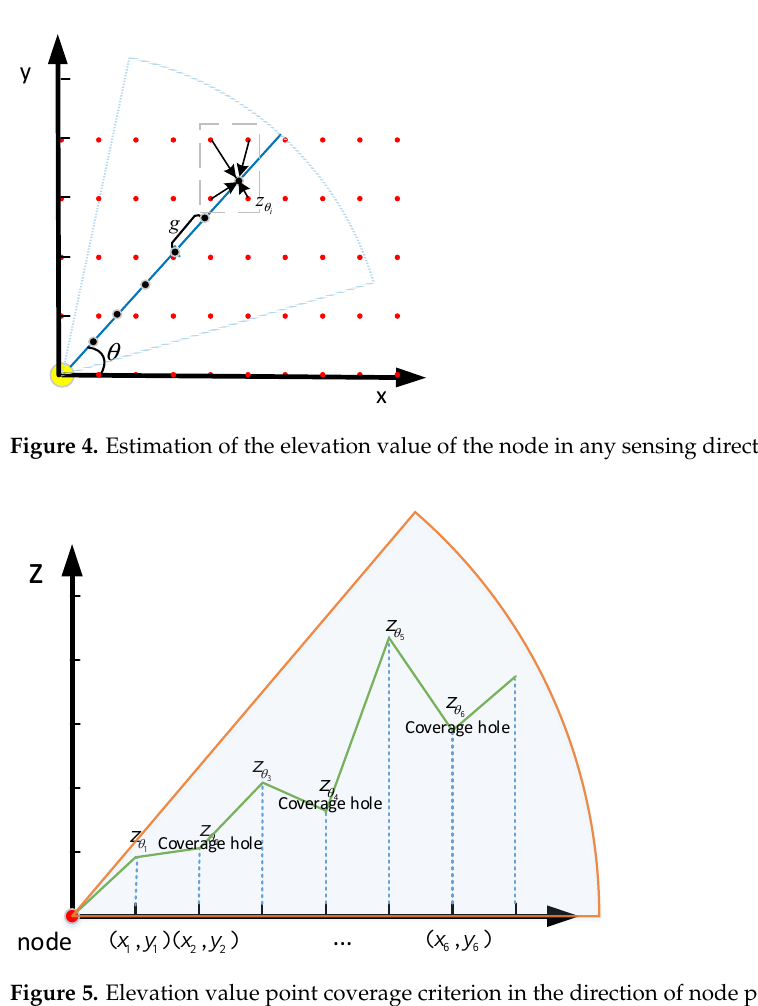
tual range r in the perceptual direction θ can be obtained. blind spots, as shown in Table 1.